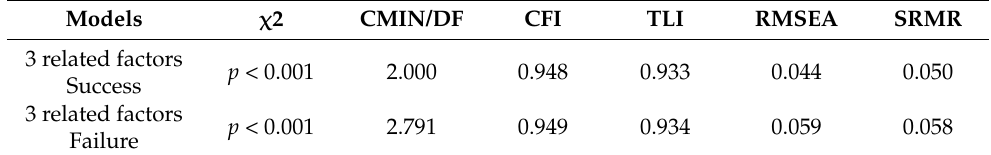
Table 1. Goodness-of-fit indices of the proposed academic success and failure attribution models.